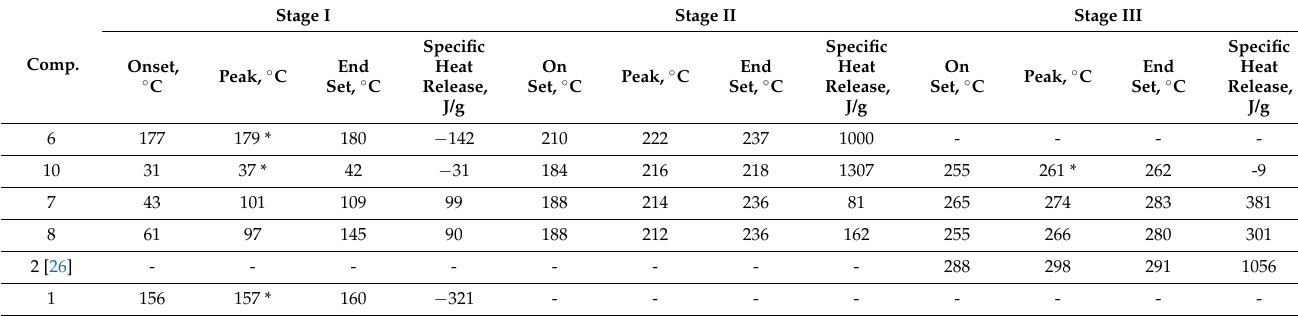
Table 2. Decomposition temperatures of 1 , 2 , 6 – 8 , and 10 as per DSC data.